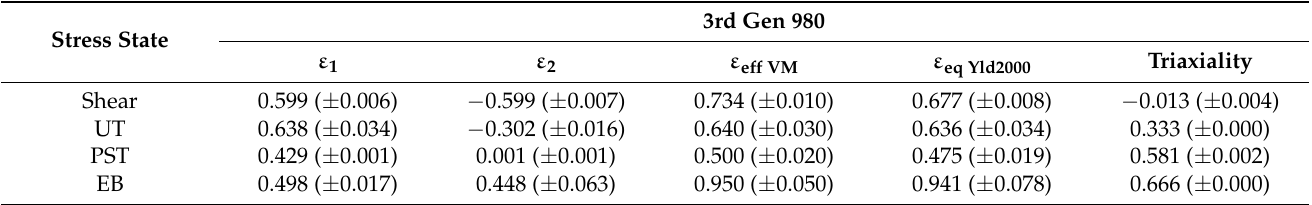
Table A5. Summary of fracture strains for the 3rd Gen 980 AHSS. Note that the von Mises effective strain corresponds to the absolute strain assuming a linear strain path. The Barlat Yld2000 equivalent strain corresponds to the accumulated work-conjugate equivalent strain integrated along the measured strain path and accounts for material anisotropy.